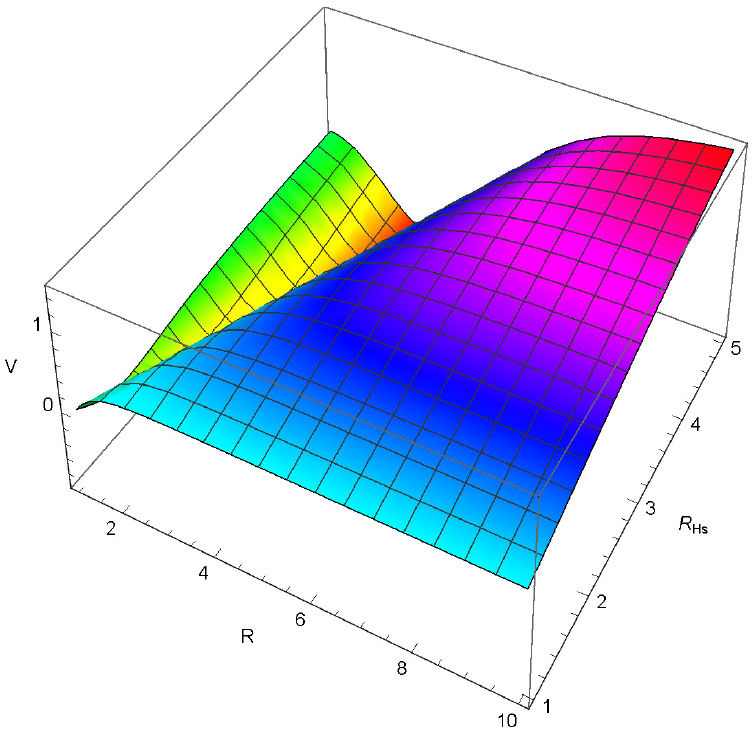
Figure 24. Solution of V ( φ 2 ) for p = 4. The evolution of V ( φ 2 ) is obtained using Equations (32) and